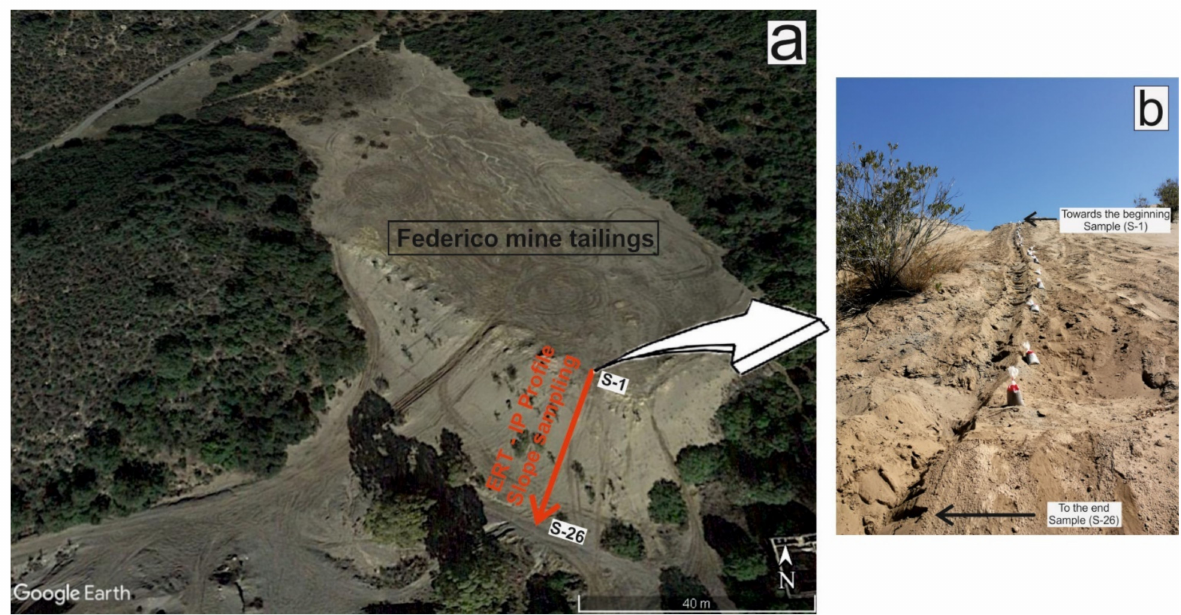
Figure 2. ( a ) Orthophoto of the tailing dam. The location of the ERT-IP profile and sampling location in the tailings is indicated. ( b ) Sampling points on the slope of the dam and the position of the samples S-1 (top) and S-26